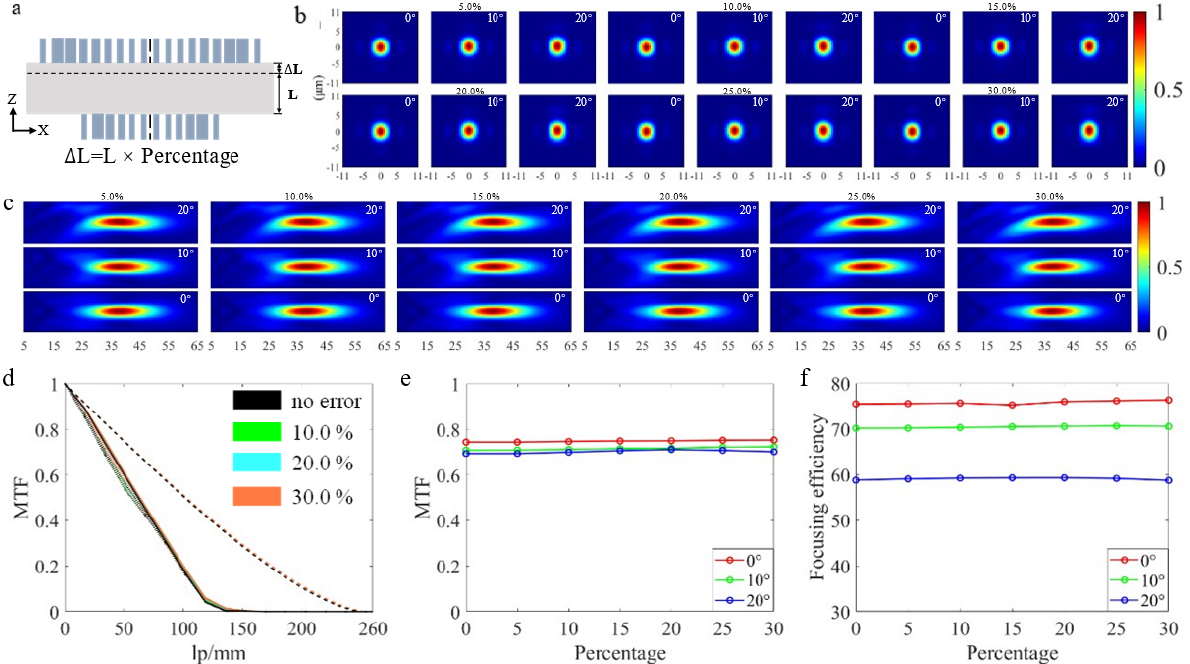
Figure 7. ( a ) Schematic diagram of spacer thickness error. ( b , c ) Light intensity distribution along XY and XZ direction at different FOV under various error conditions. ( d ) MTF curves at different FOVs under the conditions of various errors and no − error, the double dashed line represents the diffraction limit, the solid line represents the 0 ◦ FOV; the dashed line represents the 10 ◦ FOV, the dot − dashed line represents the 20 ◦ FOV (the diffraction limit under each error condition coincide with the no − error one). ( e ) Line chart of MTF values at different FOV under various error and no-error conditions when the frequency is 33.33 lp/mm. ( f ) Focusing efficiency at different FOV under various error and no − error